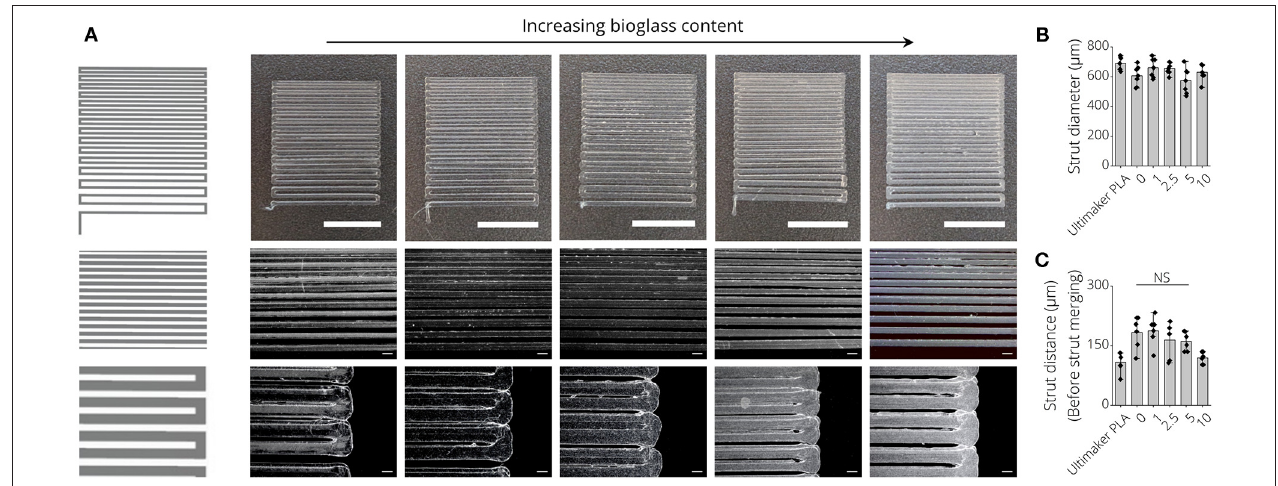
FIGURE 2 | Printability assessment of PLA-BG filaments. (A) CAD model (left) and light microscopy images (right) of the FDM printed BG-laden PLA filaments into meandering structures. Scale bars: 2000 µ m (top row), 500 µ m (mid row), 200 µ m (bottom row). The light microscopy images indicate strut merging and increase in turbidity with increasing BG content. (B) Strut diameter achieved of 3D printed PLA-BG filaments with increasing BG content of 0, 1, 2.5, 5, and 10% (wt) BG in PLA, using a diameter = 400 µ m FDM nozzle ( n = 7, mean ± SD). (C) The distance between struts before strut merging occurred processing PLA-BG filaments. Strut distance before merging indicated the highest resolution possible between two struts for each material ( n = 6, mean ± SD). NS indicates no significant difference comparing the different groups with p < 0.05 by one-way ANOVA test.